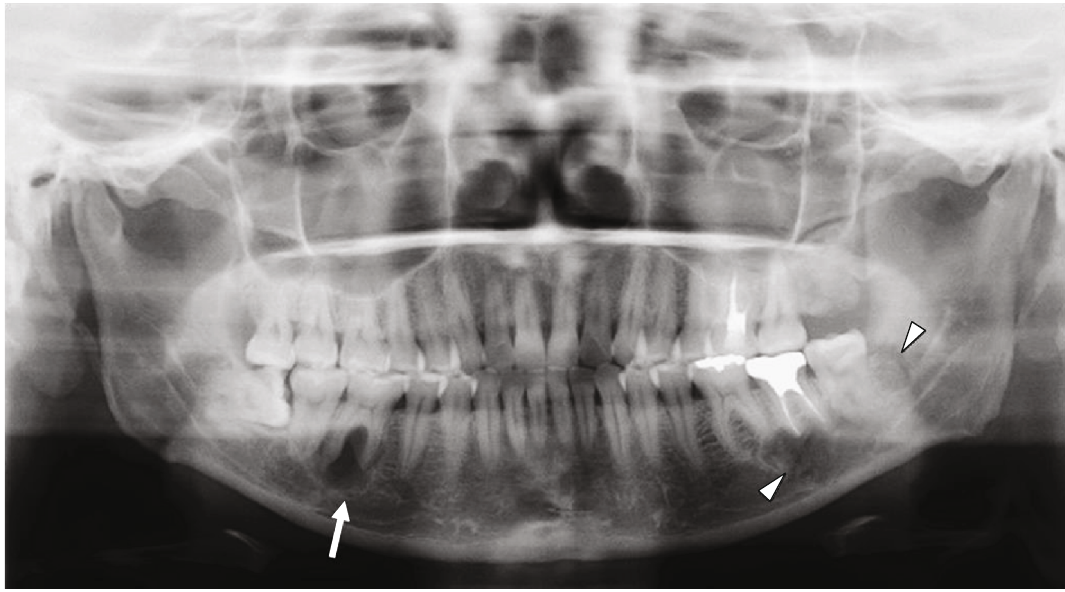
Figure 1: Panoramic X-ray radiogram. Radiolucent lesions are seen in the right mandible ( arrow ). The high-density lesion is complicated by the periapical right mandibular 2nd molar. Additionally, mixed radiolucent/radiopaque lesion was shown in the left molar region ( arrowheads